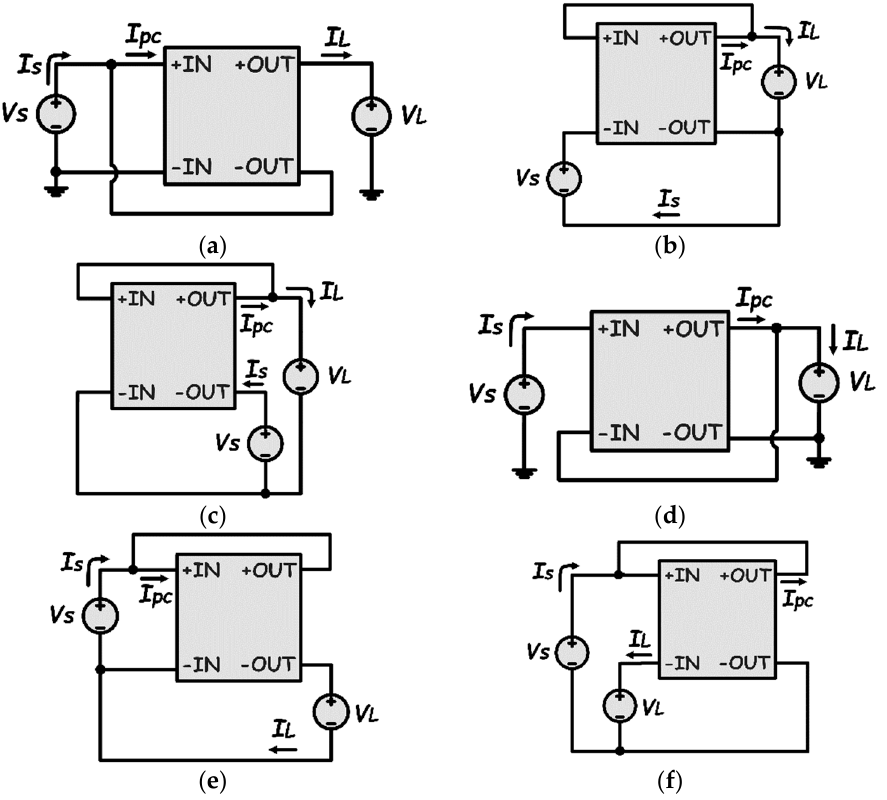
Figure 10. PPC topologies requiring isolated DC-DC converters; ( a ) IPOS step-up; ( b ) ISOP-I step-up; ( c ) ISOP-II step-up; ( d ) ISOP step-down; ( e ) IPOS-I step-down; ( f ) IPOS-II step-down.